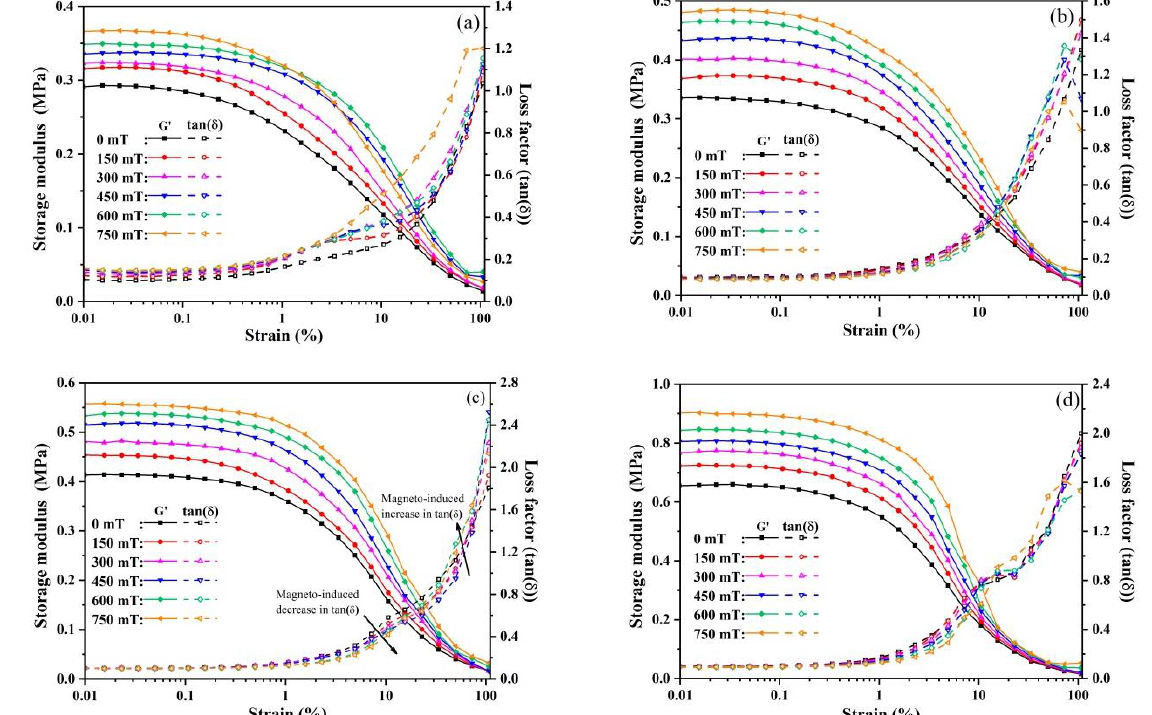
Figure 9. The storage modulus G’ and loss factor δ versus strain amplitude of the MREs under various magnetic fields: ( a ) MRE-0; ( b ) MRE-1; ( c ) MRE-3; and ( d ) MRE-5.